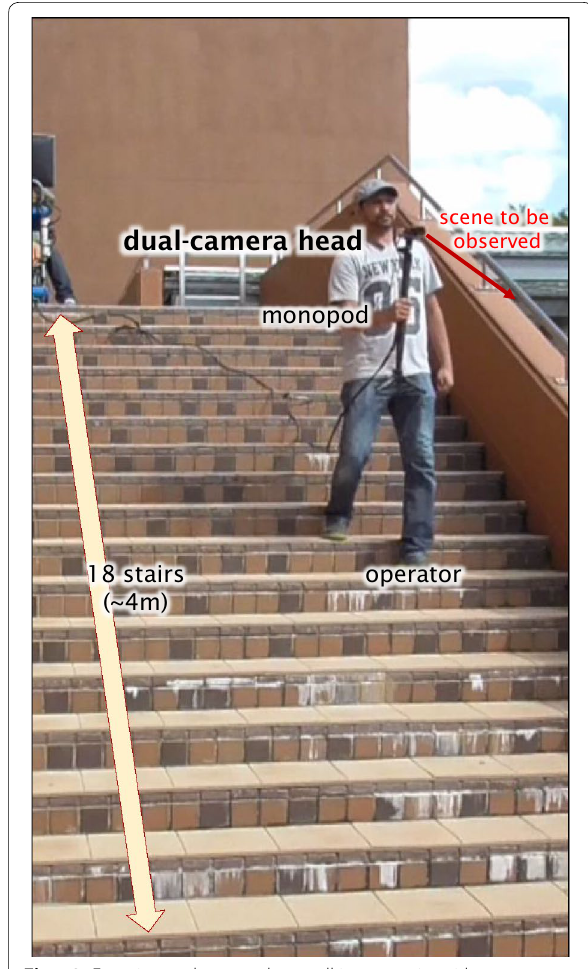
Fig. 14, the JDs in both the horizontal and vertical direc- tions time-varied at approximately 1 Hz, correspond- ing to the frequency of the camera ego-motion, which was determined by the relative geometrical relationship between the dual-camera head and the static background trees. It can be observed that the SDs were obtained as the low-frequency component by reducing the high- × 2048 frequency jitter component, and that the 2048 Fig. 13 Experimental scene when walking on stairs with a dual-camera images were stabilized so as to significantly reduce the apparent motion of the background objects such as trees and a handrail of stairs in the images, as illustrated in Fig. 16b. We confirmed that the camera jitter with the operator’s quick hand motion and the 1 Hz camera jitter in the experiment were correctly measured as the back- × 1.30 from the operator, an area of 1.30 m corresponded ground objects were always observed, with naked eyes in real time, as semi-stationary objects in the stabilized × 0.55 × 496 an area of 0.60 m observed in a 512 image of images when they were displayed on a computer display. camera 1. The threshold parameters in the feature extrac- By selecting the feature points in the static background = 5 × 10 7 = = (cid:31) tion step were set to and P 0 15, and M T for feature point matching, our hybrid-camera system 300 feature points or less were selected for feature point × 2048 can correctly stabilize 2048 images in real time matching. The cut-off frequency in the jitter sensing step without disturbance from the dynamically changing = was set to f cut 0.5 Hz. to reduce the 1 Hz camera jitter appearances around the walking persons when assisted in the experiment. by feature-point-based HFR-jitter sensing at 1000 fps